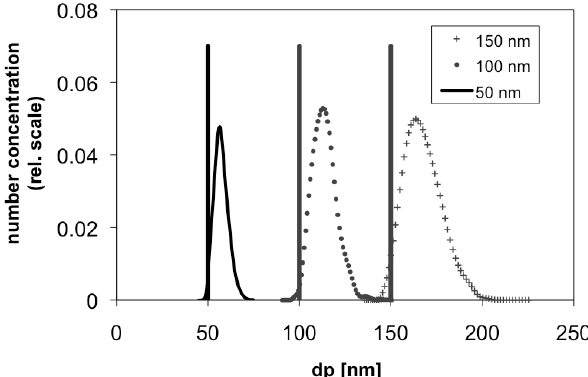
Fig. 1. Typical humidified size distributions as measured by the H-TDMA for particles with nominal dry diameters of d p = 50nm, 100nm, and 150nm (vertical lines). Figure 1. Typical humidified size distributions as measured by the H-TDMA for 6 particles with nominal dry diameters of d p = 50 nm, 100 nm, and 150 nm (vertical 7 lines). 8